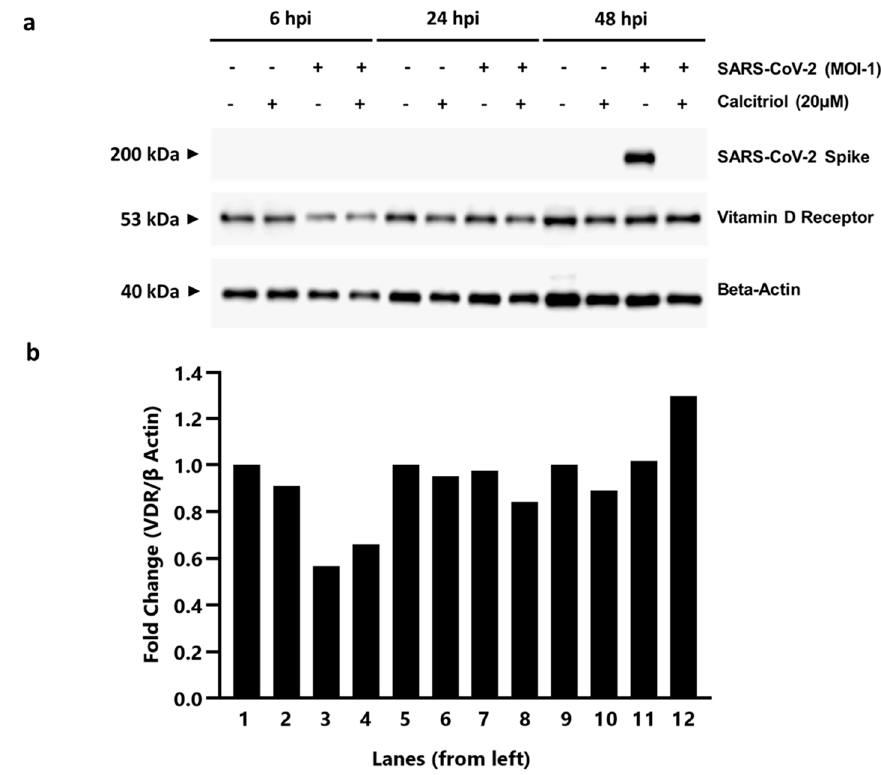
Figure 5. Western blot analysis of SARS-CoV-2 spike and VDR proteins in Vero E6 cells. ( a ) Vero E6 cells are either mock infected with media ( − ) or with SARS-CoV-2 (+) for 1 h. After 1 h post-infection, the cells are then either untreated ( − ) or treated (+) with 20 µ M calcitriol for 6-, 24- and 48- hours before harvesting of total cell lysate. ( b ) Densitometry quantitation of protein expression levels is shown as fold changes to beta-actin. Full-length blots are shown in Supplementary Figure S1.